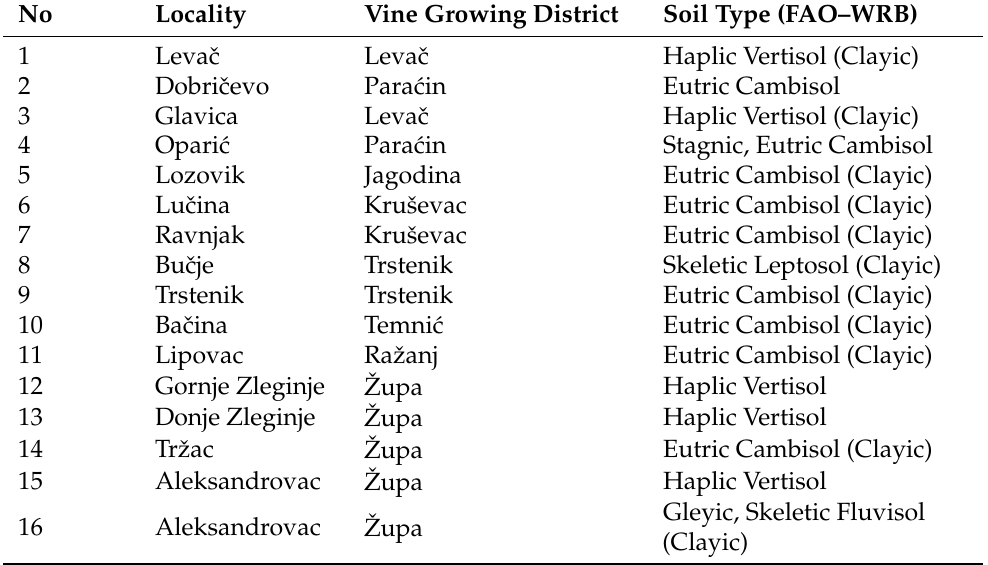
Figure 3. Some localities of observed vineyards: ( a ) Trstenik, ( b ) Ba č ina, ( c ) Glavica. Table 1. Locations, vine growing districts and soil types of the vineyards.